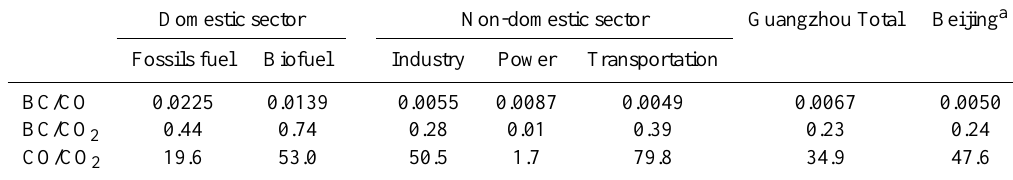
Table 7. Emission ratios of BC/CO (µgCm − 3 /ppbv), BC/CO 2 (µgCm − 3 /ppmv), and CO/CO 2 (ppbv/ppmv) derived from the inventory of Streets et al. (2003). Comparison of the emission ratios of Guangzhou to those of Beijing derived from the total emissions using the same inventory data.